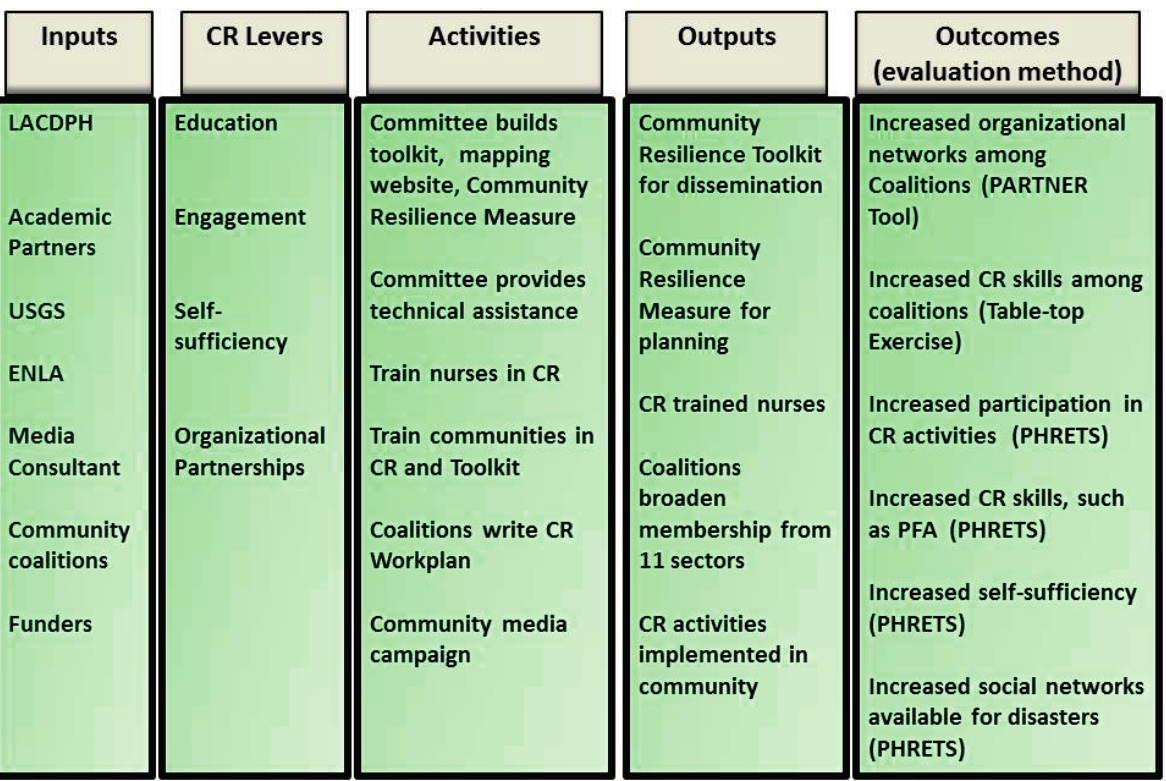
Figure 2. Logic Model for